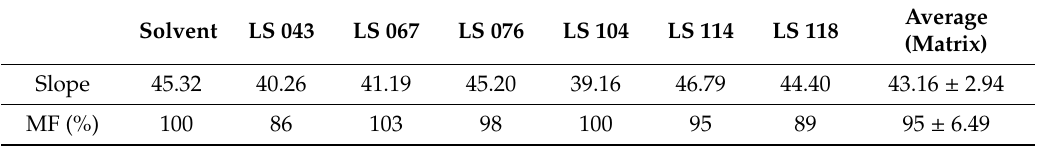
Table 2. Matrix e ff ect on β -ODAP determination in di ff erent samples. MF—Matrix Factor.